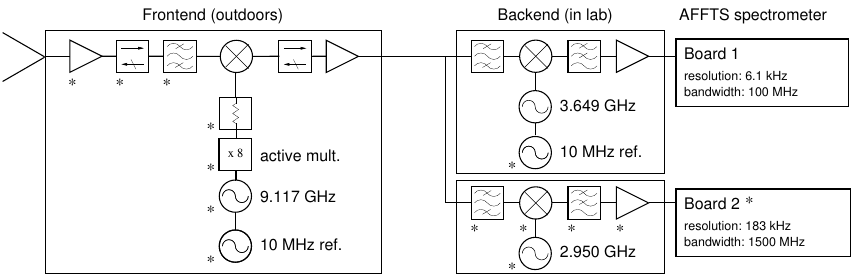
Figure 2. Block diagram of the upgraded receiver electronics of WIRA. For the wind retrieval described in this paper only the data from the narrow band spectrometer (board 1) are used. The components that have been modified or added since the prototype described in Rüfenacht et al. (2012) are marked with an asterisk.